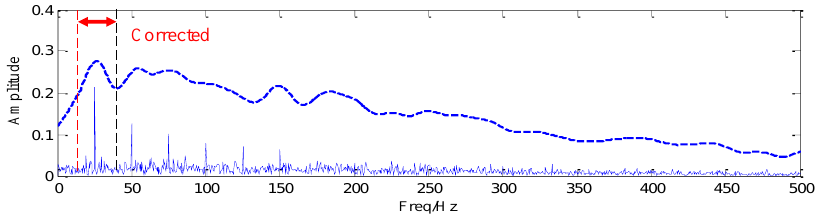
denotes the corrected border.